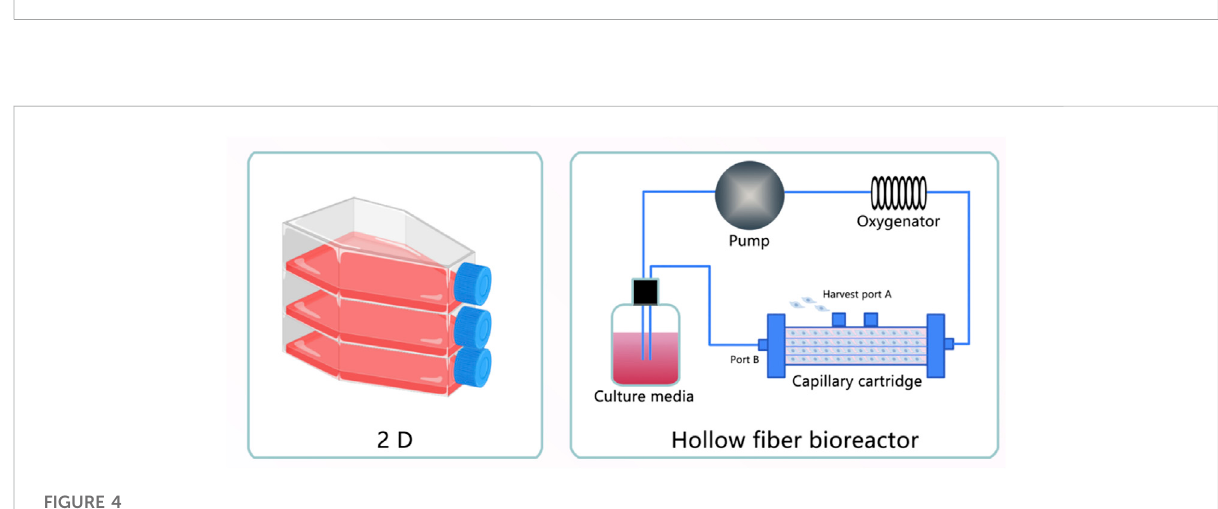
FIGURE 4 Exosomes obtained under three-dimensional (3D) Culture. (1) Exosomes extracted from MSC cultured in fi ve-layer fl asks. (2) Exosomes extracted from MSC cultured in a hollow fi ber